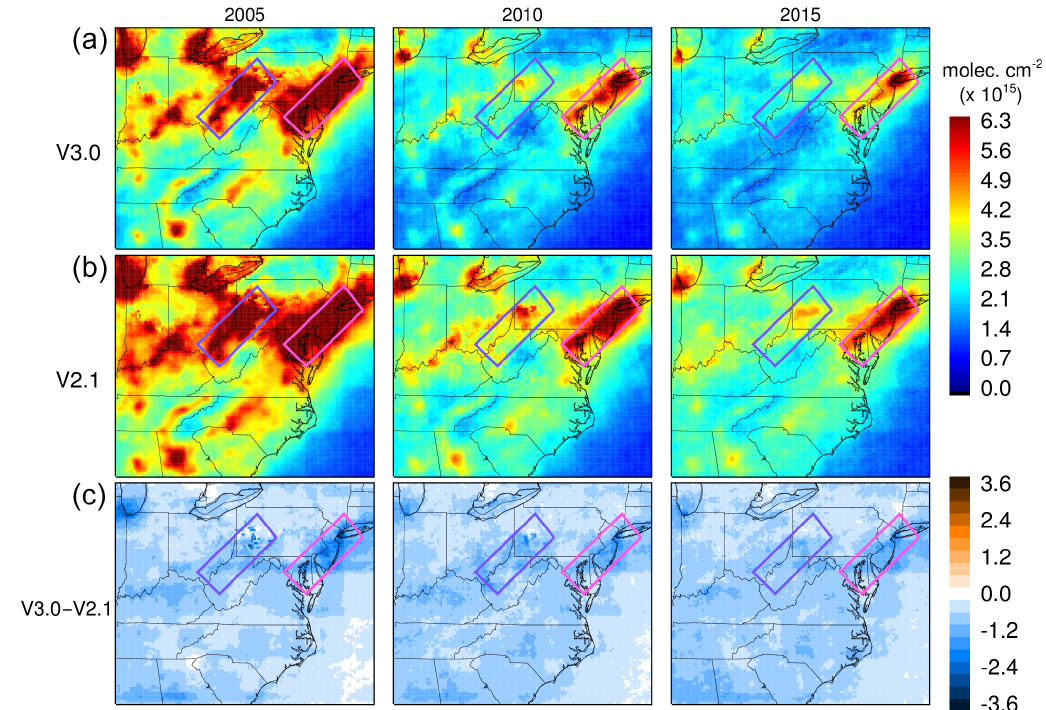
Figure 5. Annual average OMI NO 2 V trop maps over the eastern US for 2005, 2010, and 2015: SPv3 (a) , SPv2 (b) and the difference: SPv3 – SPv2 (c) . The blue box outlines the Ohio River valley and southwestern Pennsylvania region with the predominant emissions from coal-fired power plants (Ohio in Fig. 6). The red box outlines the megalopolis from Washington, DC to New York along the I-95 interstate highway (I-95 corridor in Fig. 6) with predominant emissions from mobile sources. The regions have been discussed in Krotkov et al.